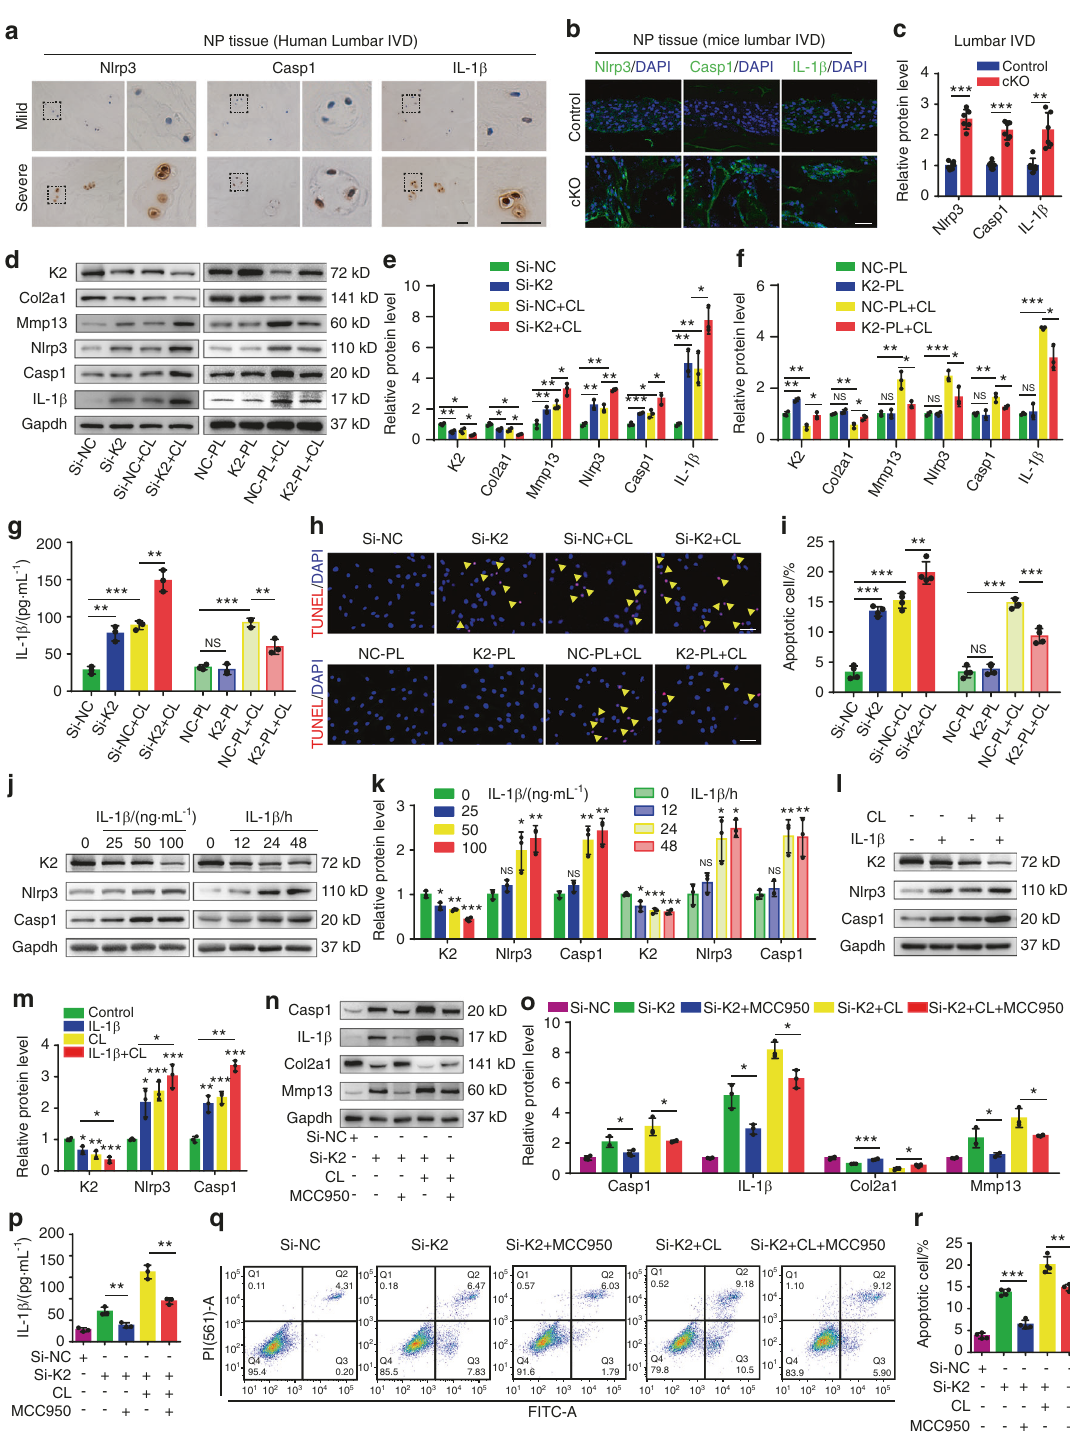
Fig. 4 Kindlin-2 deletion promotes Nlrp3 in fl ammasome activation, ECM catabolism and cell apoptosis in NP cells in vitro. a Immunohistochemical (IHC) staining of Nlrp3, Caspase-1(Casp1) and IL-1 β in human NP samples. Scale bar, 50 μ m. b , c IF staining of Nlrp3, Casp1 and IL-1 β in NP tissues in lumbar IVDs of control and cKO mice at 8 months of age. Scale bar, 50 μ m. d – f Western blotting analyses of K2, Col2a1, Mmp13, Nlrp3, Casp1, and IL-1 β in NP cells, which were transfected with negative control siRNA (si-NC) or K2 siRNA (si- K2), negative control plasmid (NC-PL) or K2 plasmid (K2-PL), and then treated with or without compression loading (CL) treatment. n = 3. g The levels of IL-1 β in the conditioned media of cultured NP cells treated as in ( d ), as detected by ELISA. n = 3. h , i TUNEL staining of NP cells, which were treated as in (d). Scale bar, 50 μ m. n = 4. j – m Western blotting analyses of K2, Nlrp3, and Casp1 in NP cells, which were treated with different doses (0, 25, 50, 100 ng·mL − 1 ) of IL-1 β for 24 h or 50 ng·mL − 1 IL-1 β for different time (0, 12, 24, 48 h) with or without CL treatment. n = 3. n , o Western blotting analyses of Casp1, IL-1 β , Col2a1, and Mmp13 in NP cells, which were transfected with si-NC or si-K2, pretreated with or without MCC950, and then treated with or without CL treatment. n = 3. p The levels of IL-1 β in the conditioned media of cultured NP cells treated as in ( n ), as detected by ELISA. n = 3. q , r Apoptosis rate of NP cells, which were treated as in ( n ), was measured by fl ow cytometry analyses. n = 4. NS no statistical signi fi cance, * P < 0.05, ** P < 0.01, *** P < 0.001 Bone Research (2022)